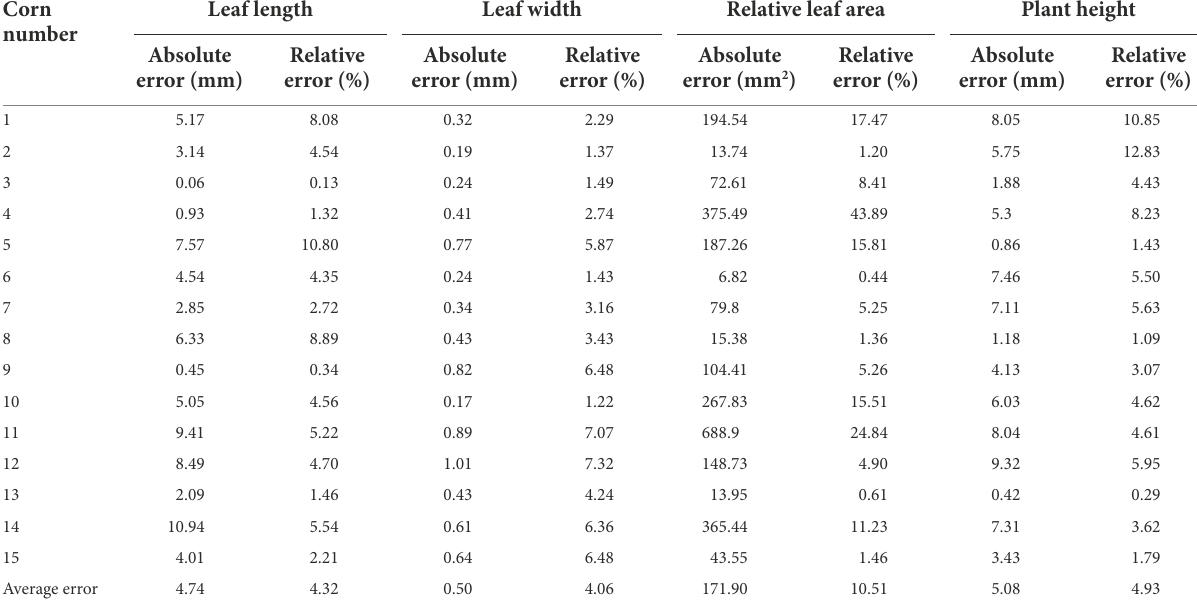
TABLE 3 Error analysis of phenotypic parameters of maize. Corn